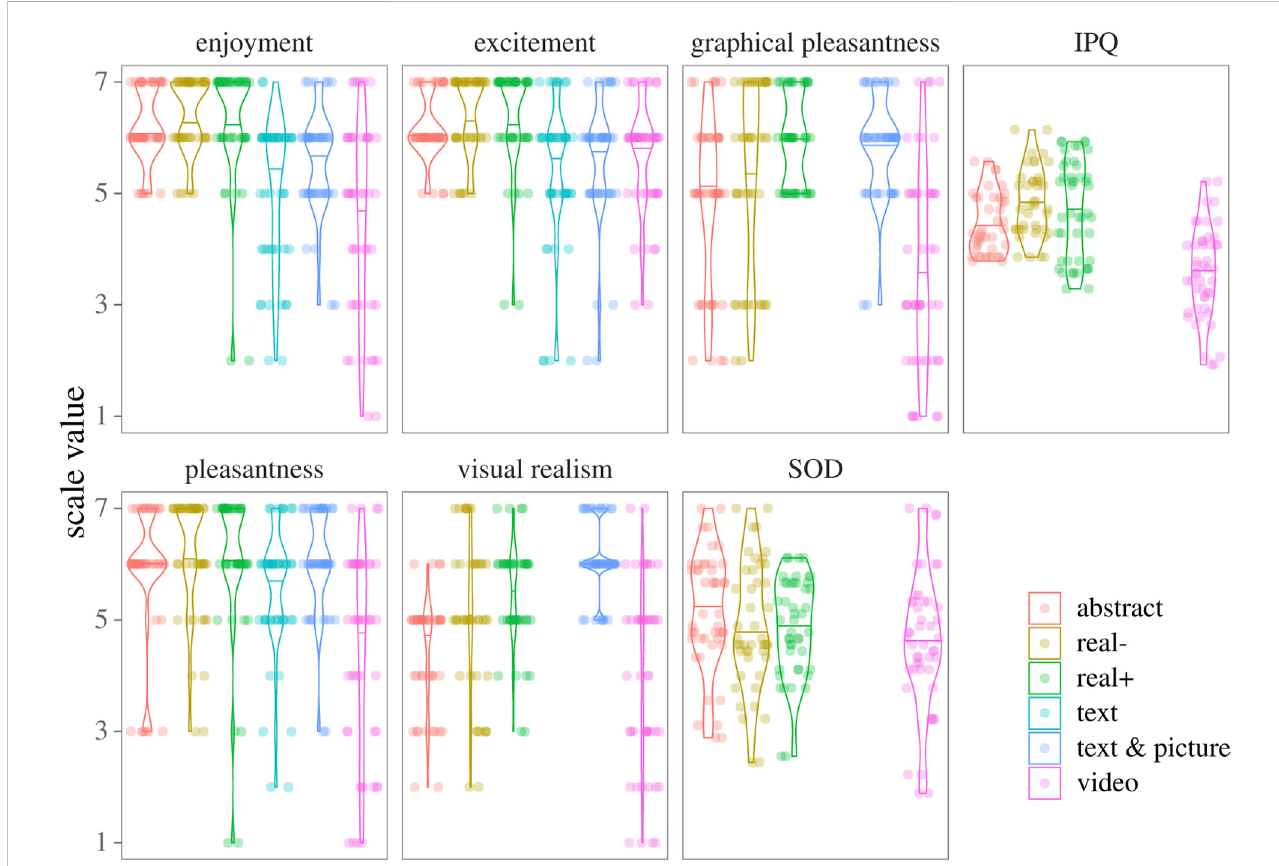
FIGURE 2 Manipulation check. Experience variables are based on one item each. IPQ and SOD represent average questionnaire scores.